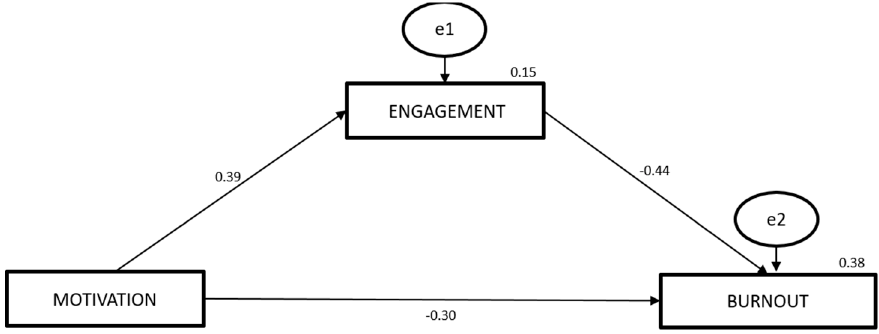
Figure 1. Model for the path analysis between motivation, engagement, and burnout.